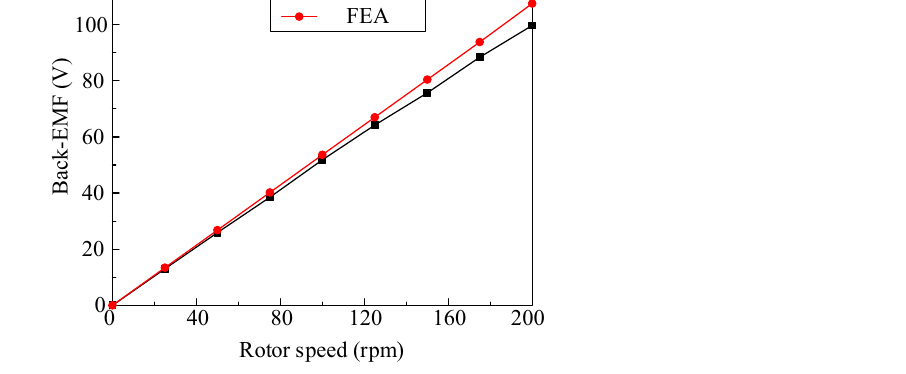
Figure 14. Comparison of the measured and FEA effective values of no-load back-EMF at different speeds.